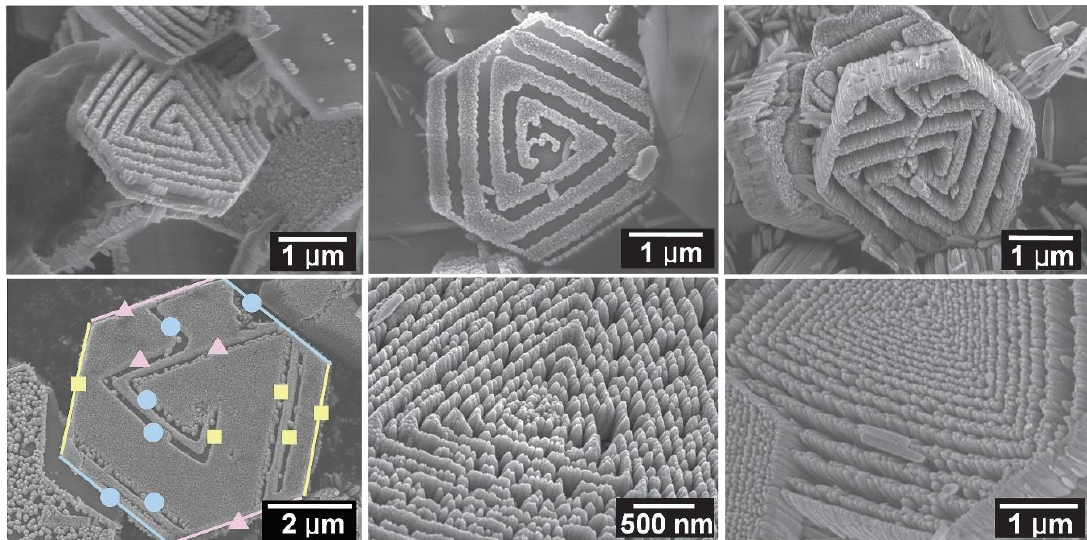
Figure 28. SEM images of the ZnO nanorod/ZnAl:LDH heterostructures with ZnO nanorod patterns on ZnAl:LDHs. Republished with permission of © The Royal Society of Chemistry, from [723], Copyright (2009), permission conveyed through Copyright Clearance Center, INC. All rights reserved. In order to re-use permission must be obtained from the rightsholder.